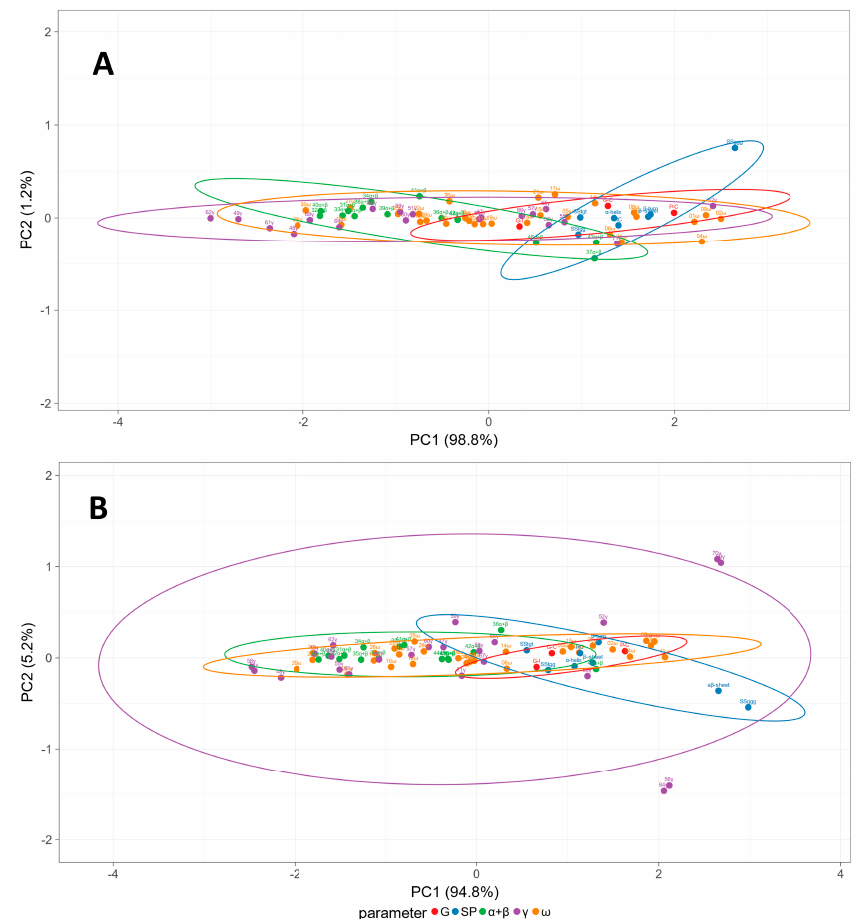
Figure 7. Principal component analysis (PCA) plot of measured parameters: gluten content, gluten index, and protein content (G); secondary structure parameters estimated from Raman spectra (SP); and proportions of gliadin fractions ( α + β , γ , ω ). Prediction ellipses mark an area where a new observation from the same group will fall with a probability of 0.95. The upper panel ( A ) presents results for wasko.gl − whereas lower panel ( B ) presents data for